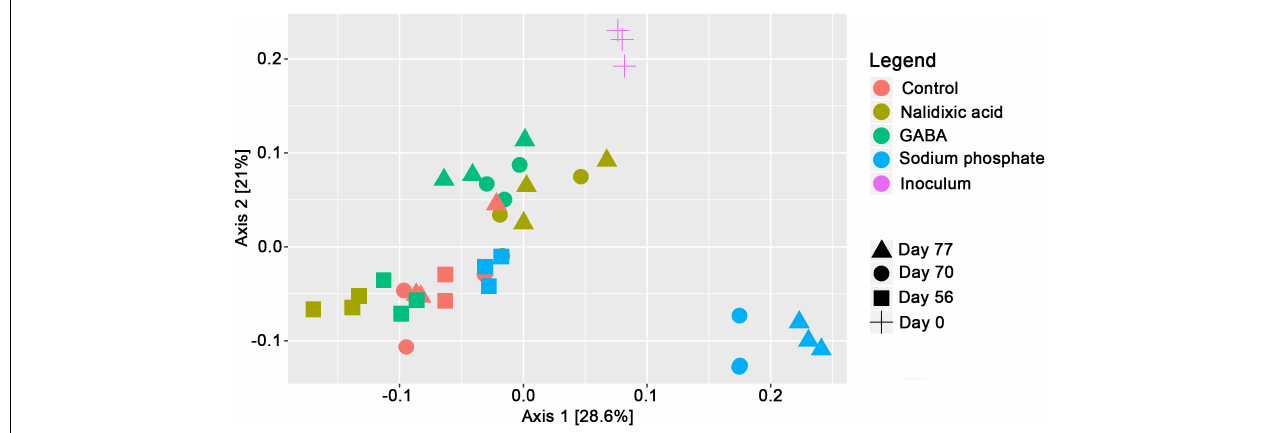
FIGURE 4 | Principal component analysis of 16S-rRNA gene amplicon sequences after calculation of Bray-Curtis dissimilarities at the genus